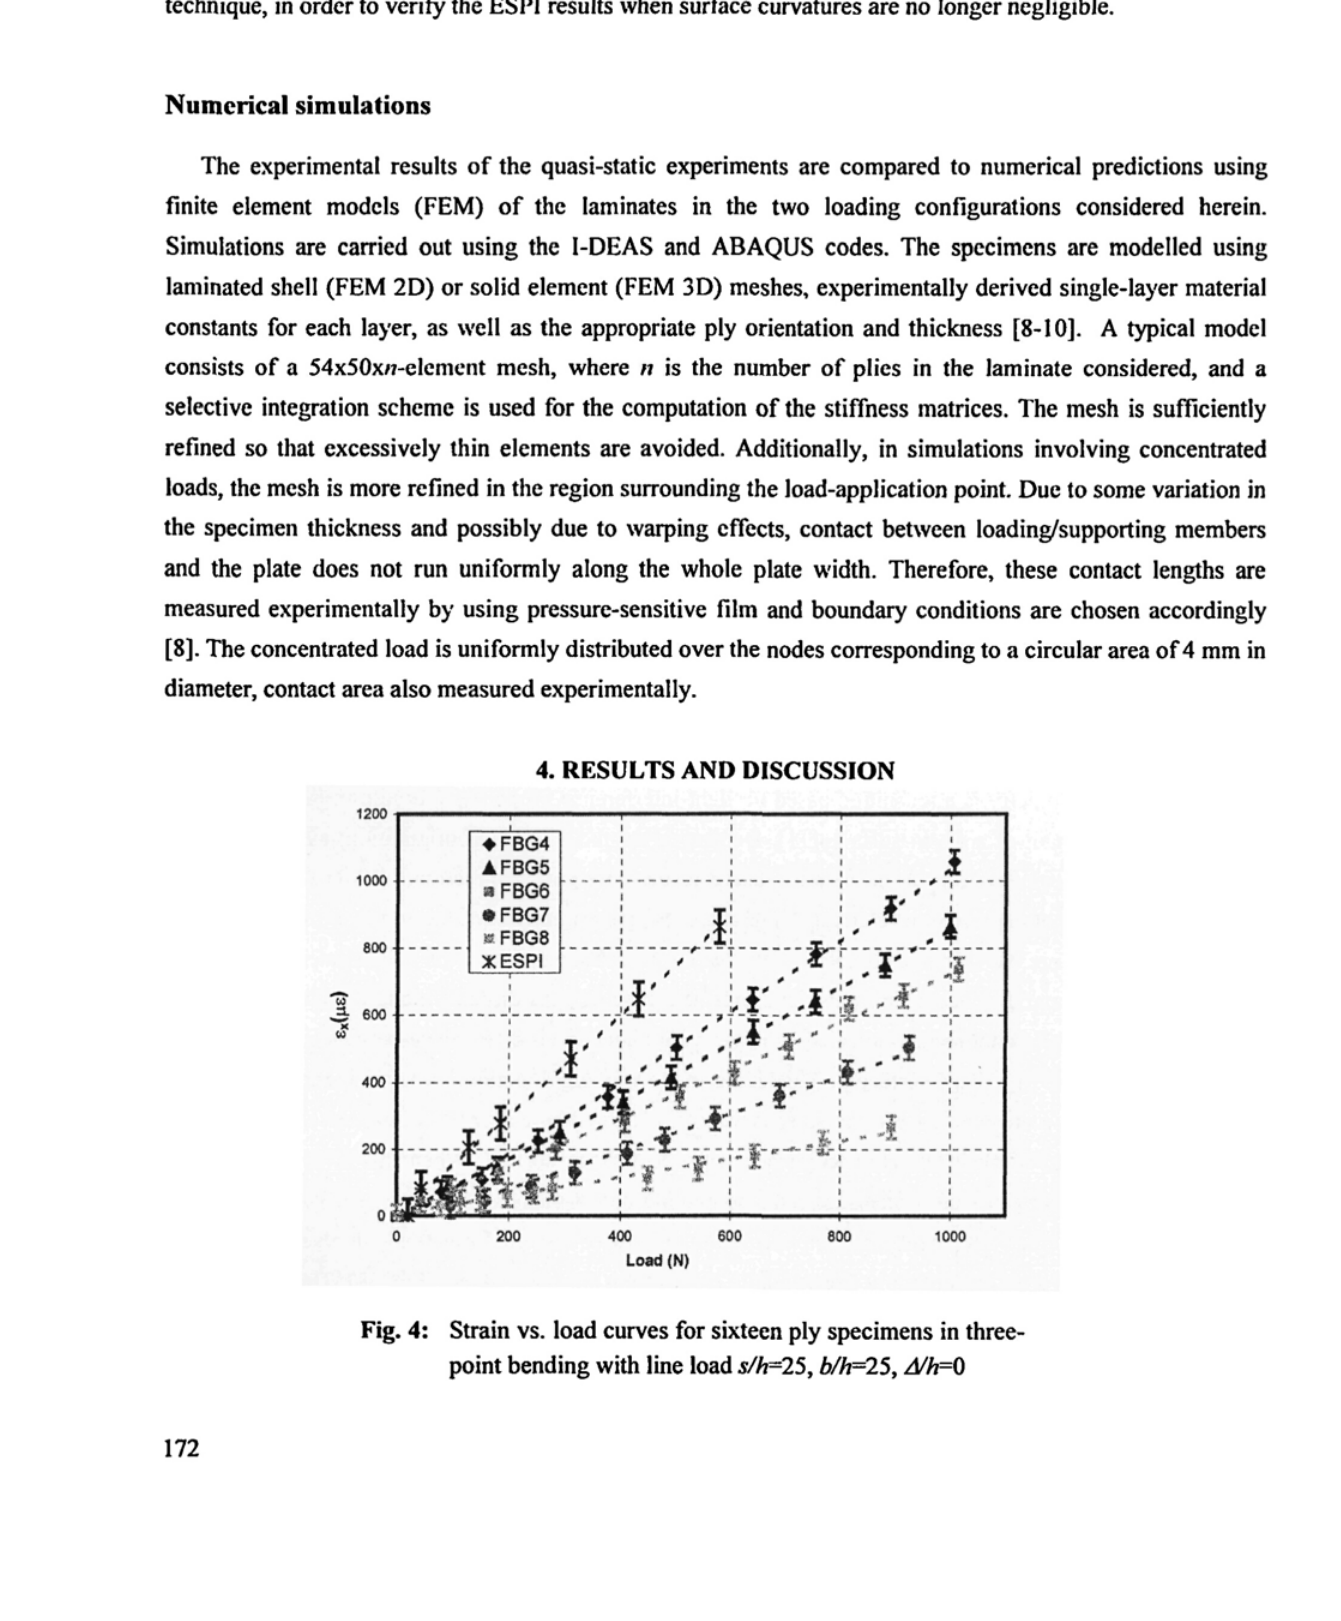
Fig. 4: Strain vs. load curves for sixteen ply specimens in three- point bending with line load i/A=25, b/h=25,